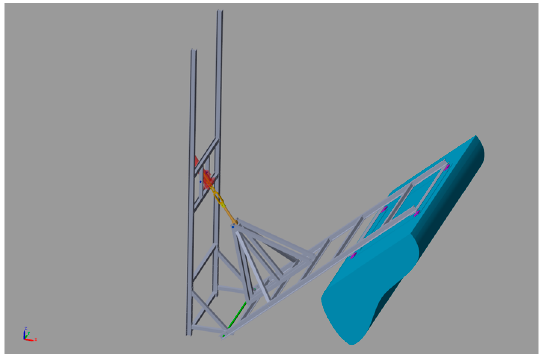
Figure 2. Simplified WEC model developed in a SimWise 4D environment.